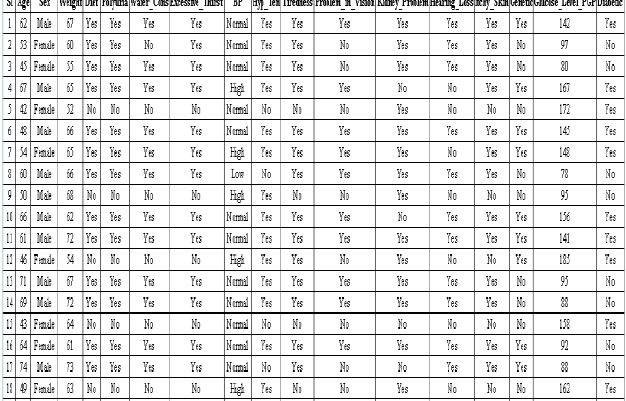
Table 8. Sample dataset of diabetic